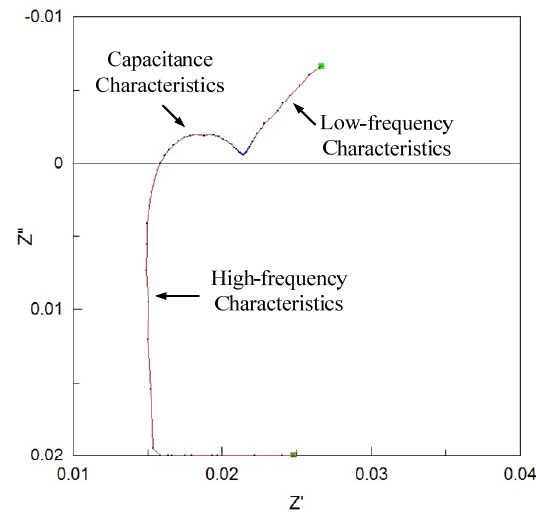
Figure 9. Nyquist plot of a Li-ion battery.